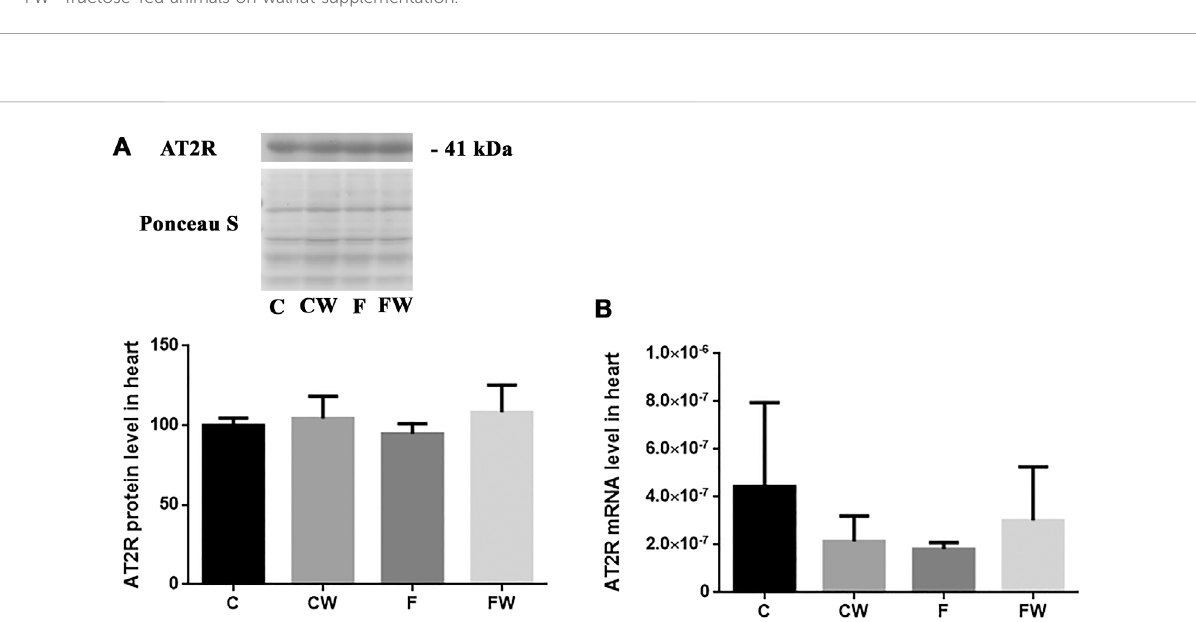
FIGURE 4 Effects of fructose-rich diet and walnut supplementation on (A) protein and (B) mRNA level of AT2R in heart of experimental rats. Values are means with standard deviations represented by vertical bars for 3 samples, each consisting of 3 pooled hearts of the same group. C — animals